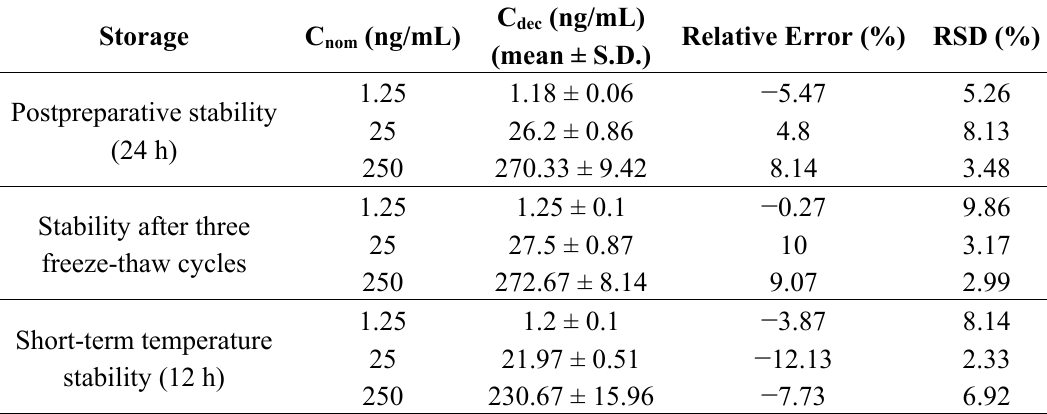
Table 3. Stability results for analysis of DHC in rat plasma (n = 6).